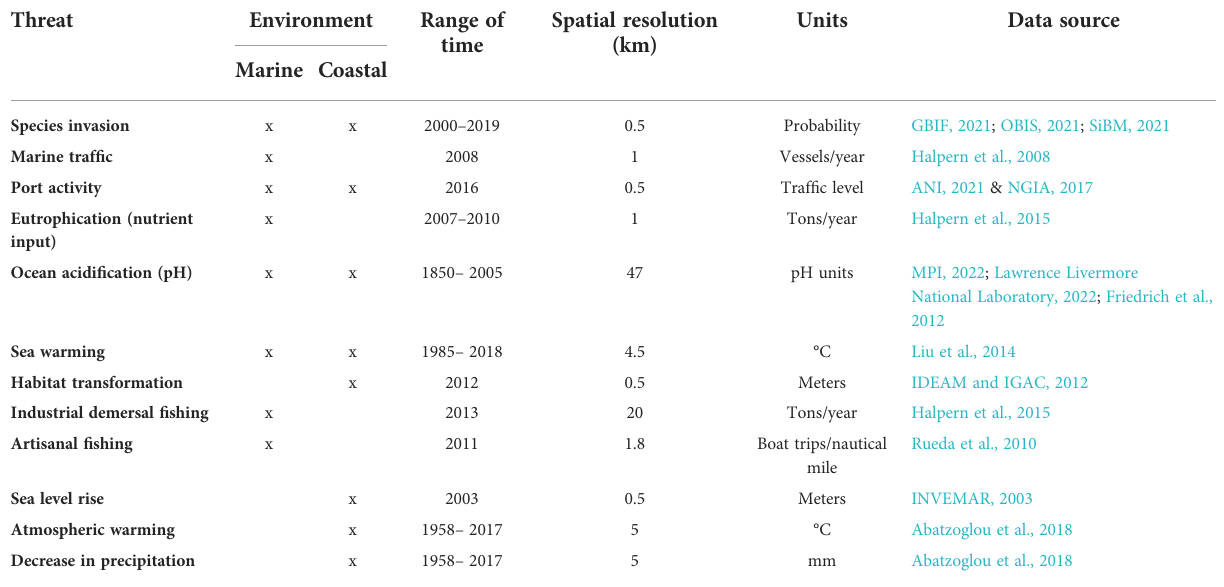
TABLE 3 Technical features of the 12 analyzed